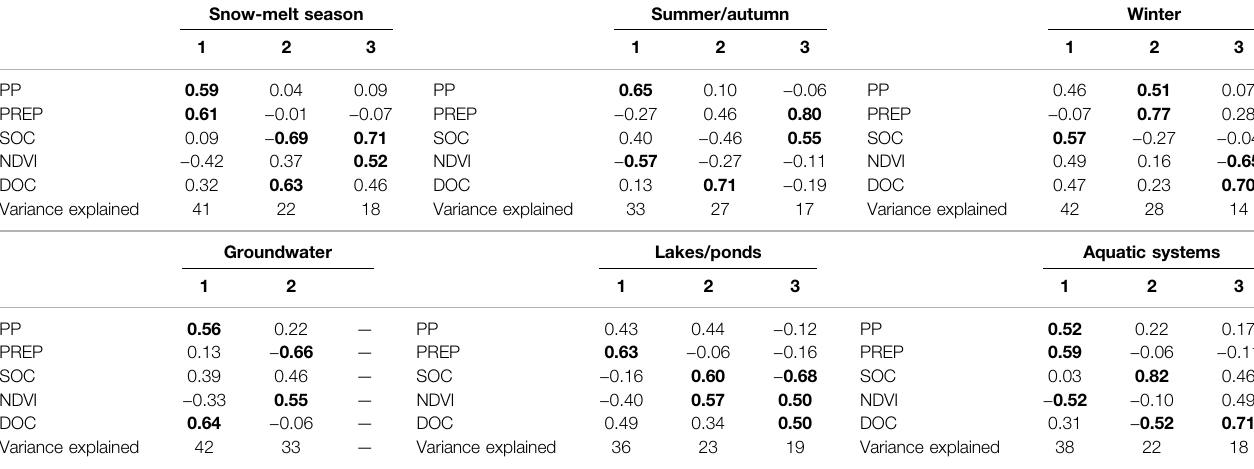
TABLE 3 | Correlations between multi-environmental variables and aquatic DOC concentrations for each principal component in a PCA